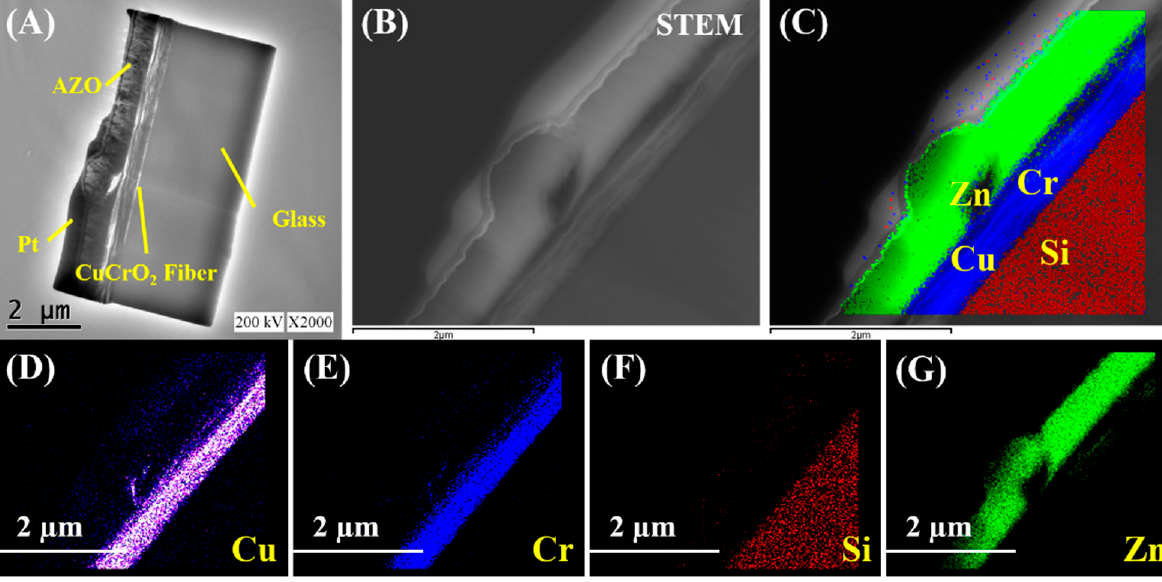
Figure 7. ( A ) TEM, ( B ) STEM, ( C ) Mix and EDX-mapping of the vertical direction of the electro-spun CuCrO 2 thin film by rotating speed of 3000 rpm, ( D ) Cu, ( E ) Cr, ( F ) Si, ( G ) Zn.